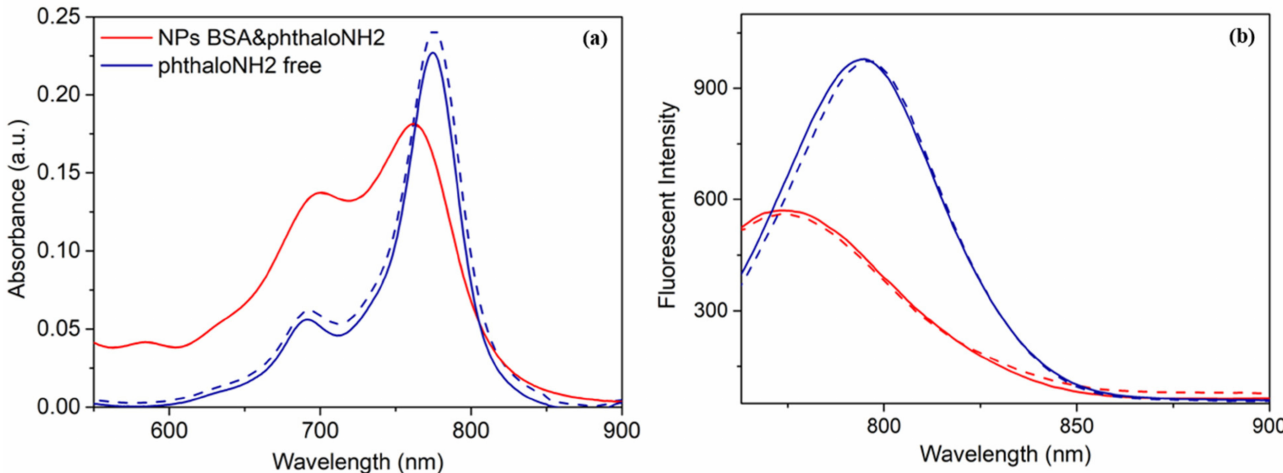
Figure 5. Absorption ( a ) and fluorescence emission ( b ) spectra recorded at 25 ◦ C (dashed line) and at 37 ◦ C (solid line) of the free photoactive agent (blue) compared with BSA&phthaloNH 2 NPs